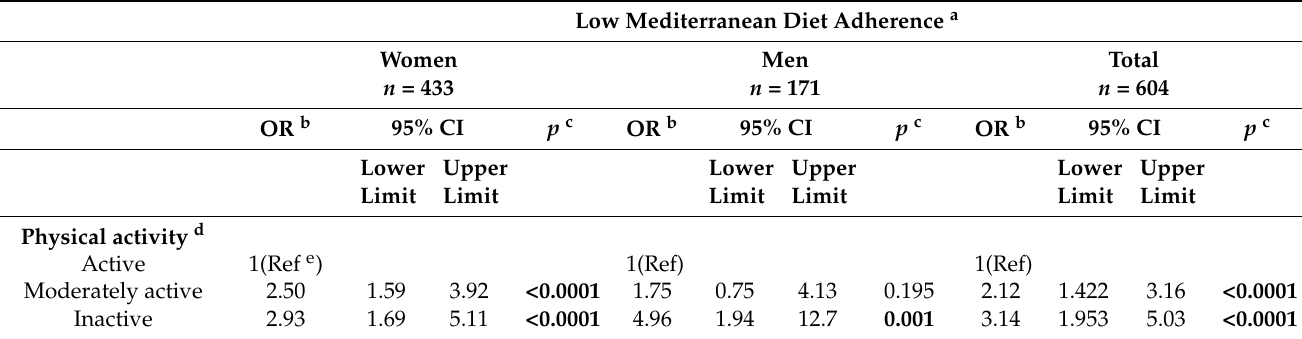
Table 6. Multivariate logistic regression analyses of Physical activity level for low Mediterranean diet